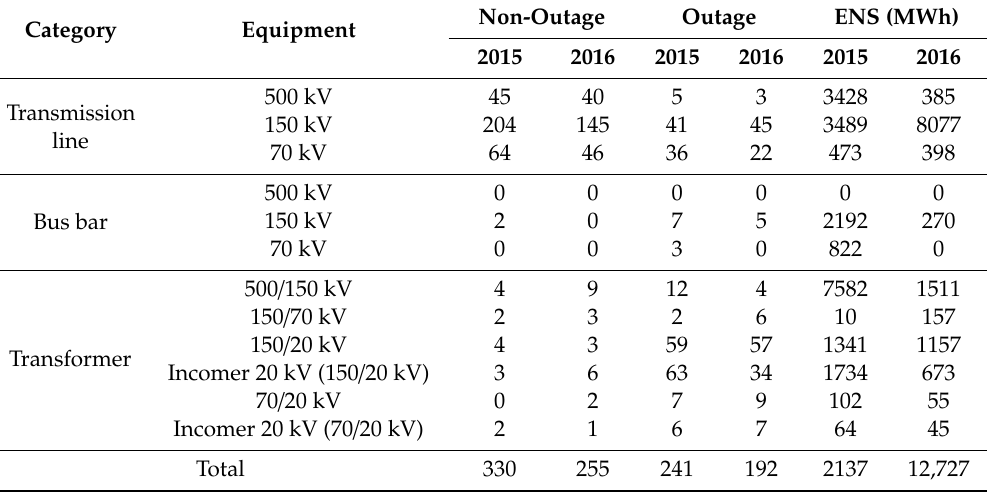
Table 3. Java-Bali transmission system failures from 2015 to 2016